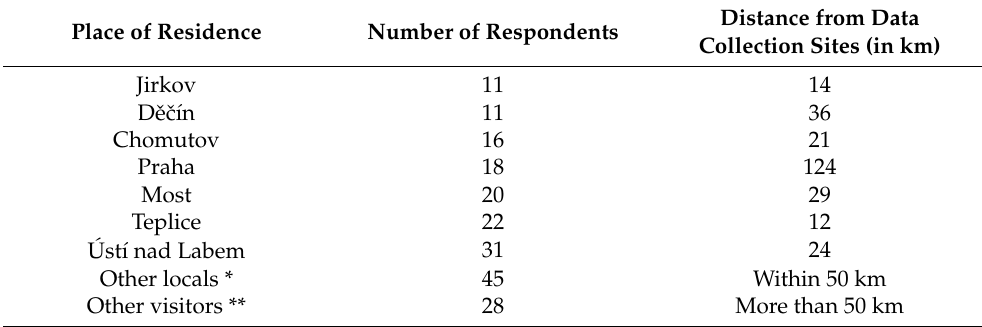
Table 3. Names of municipalities where respondents live (source: authors).